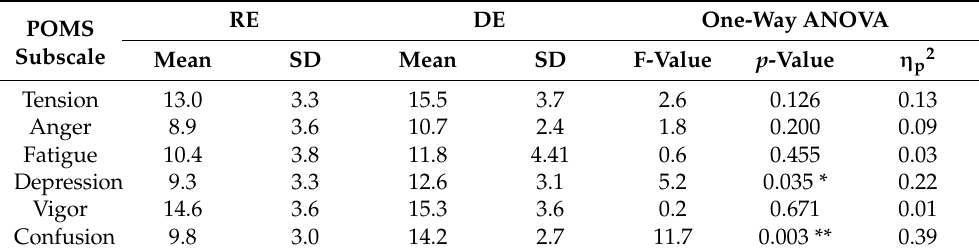
Figure 7. Comparison of POMS subscales for the RE and DE. Interpretation: red (*) and (**) indicate p < 0.05 and p < 0.01, respectively. The error bars represent the SD. Table 4. Statistics for the POMS subscale comparison between the RE and DE.